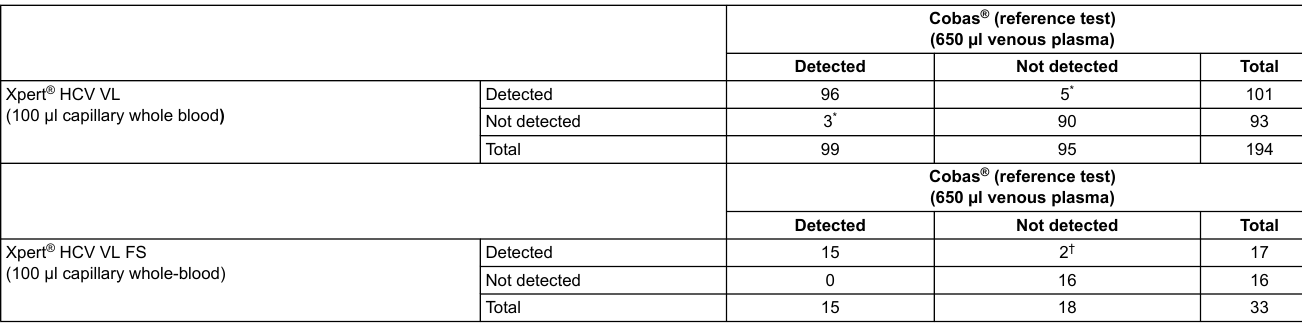
Table 2: Qualitative performance / diagnostic accuracy of the Xpert ® HCV Viral Load (VL) and the Xpert ® HCV Viral Load Finger-Stick (VL FS)